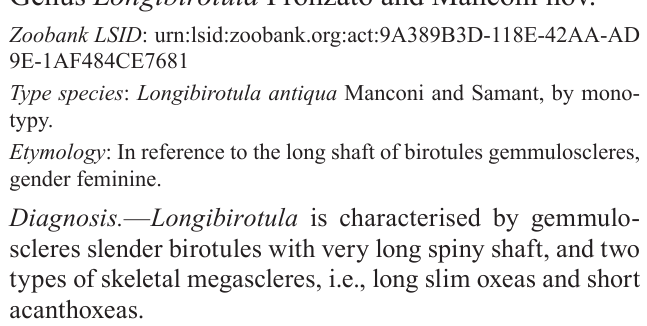
Fig. 3. Megascleres of palaeospongillid sponge Longibirotula antiqua gen. et sp. nov. from Upper Cretaceous–lower of Paleocene of Naskal GSI Quarry (India). A – H . Acanthoxeas (slides PGNU/NSKQ/SL-1–13) with large spines. Diagenetic processes affect all spicules to various degree. Scale bars 20 µm. Genus Longibirotula Pronzato and Manconi nov.